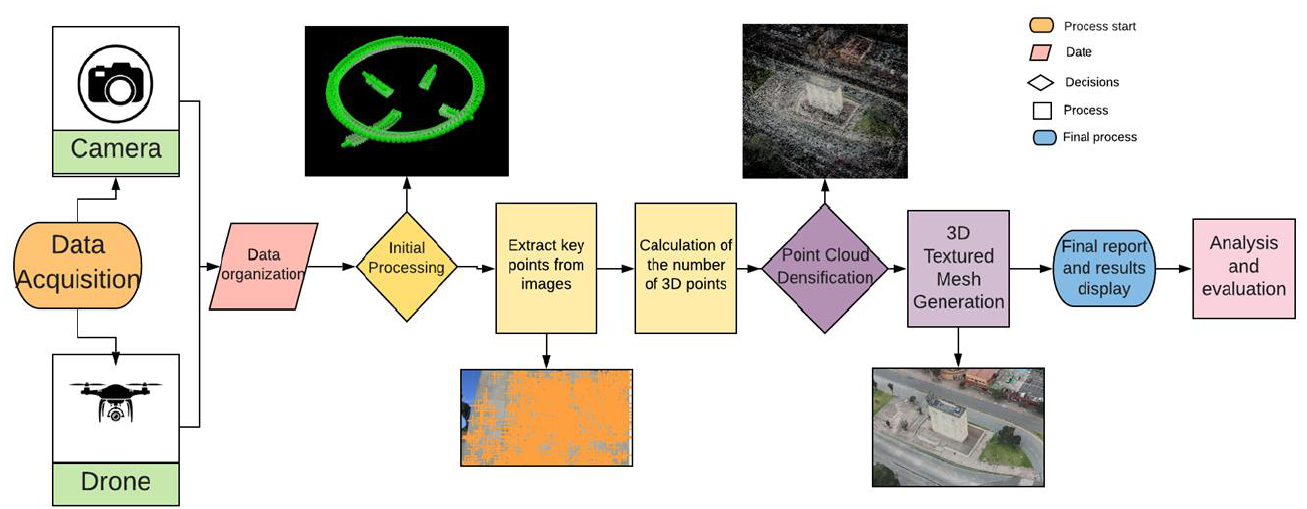
Figure 4: Processing